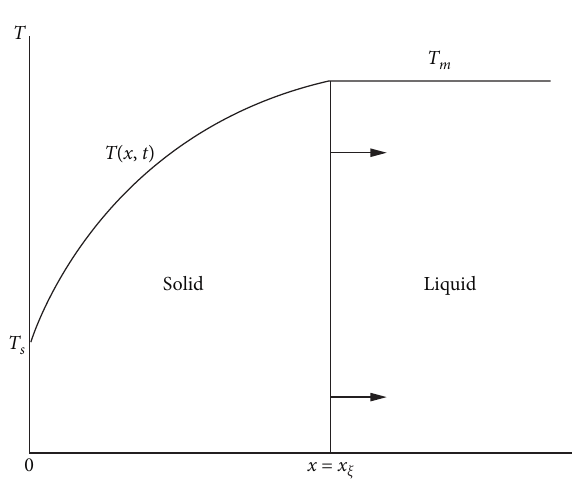
Figure 2: Coordinate for single-phase solidification.